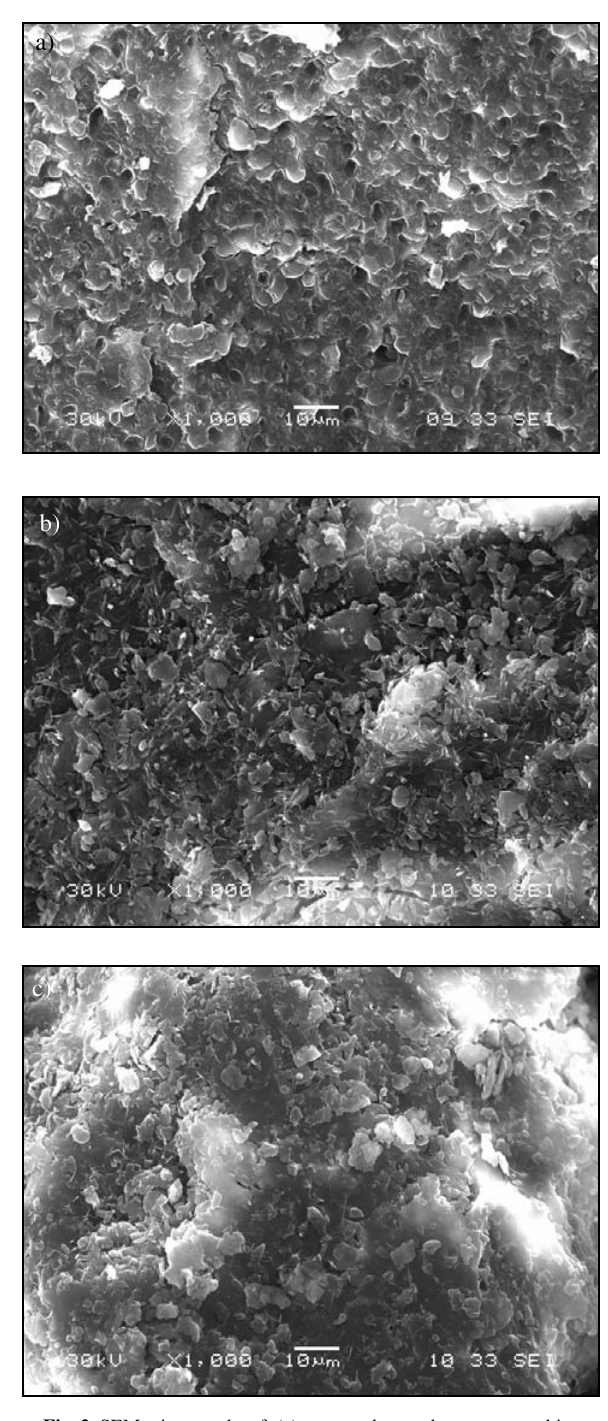
Fig. 2. SEM micrographs of: (a) untreated waste brewery yeast bio- mass (control), (b) waste brewery yeast pretreated with NaOH, (c) and untreated waste brewery yeast after Cd 2+